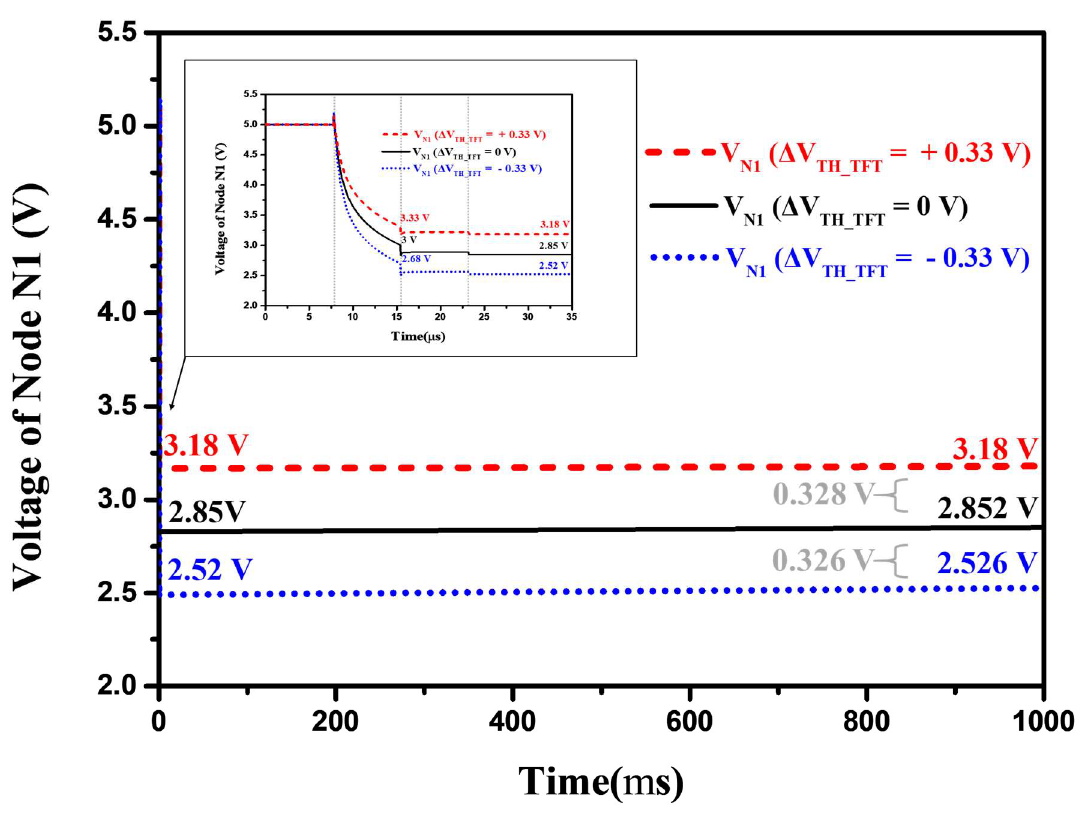
Figure 6. Simulated waveforms of the voltage of node N1 operating at 1 Hz when V TH variations in DTFT are −0.33 V, 0 V, and +0.33 V.